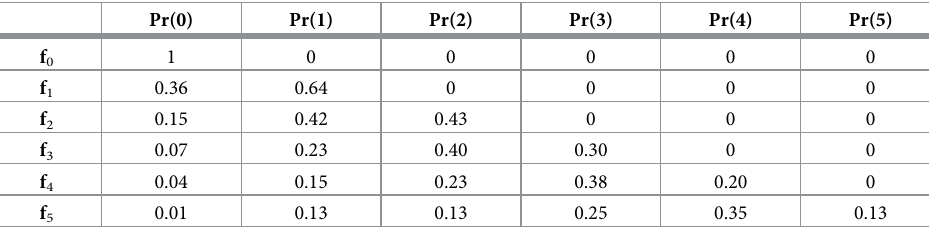
Table 2. Estimated probability mass functions.